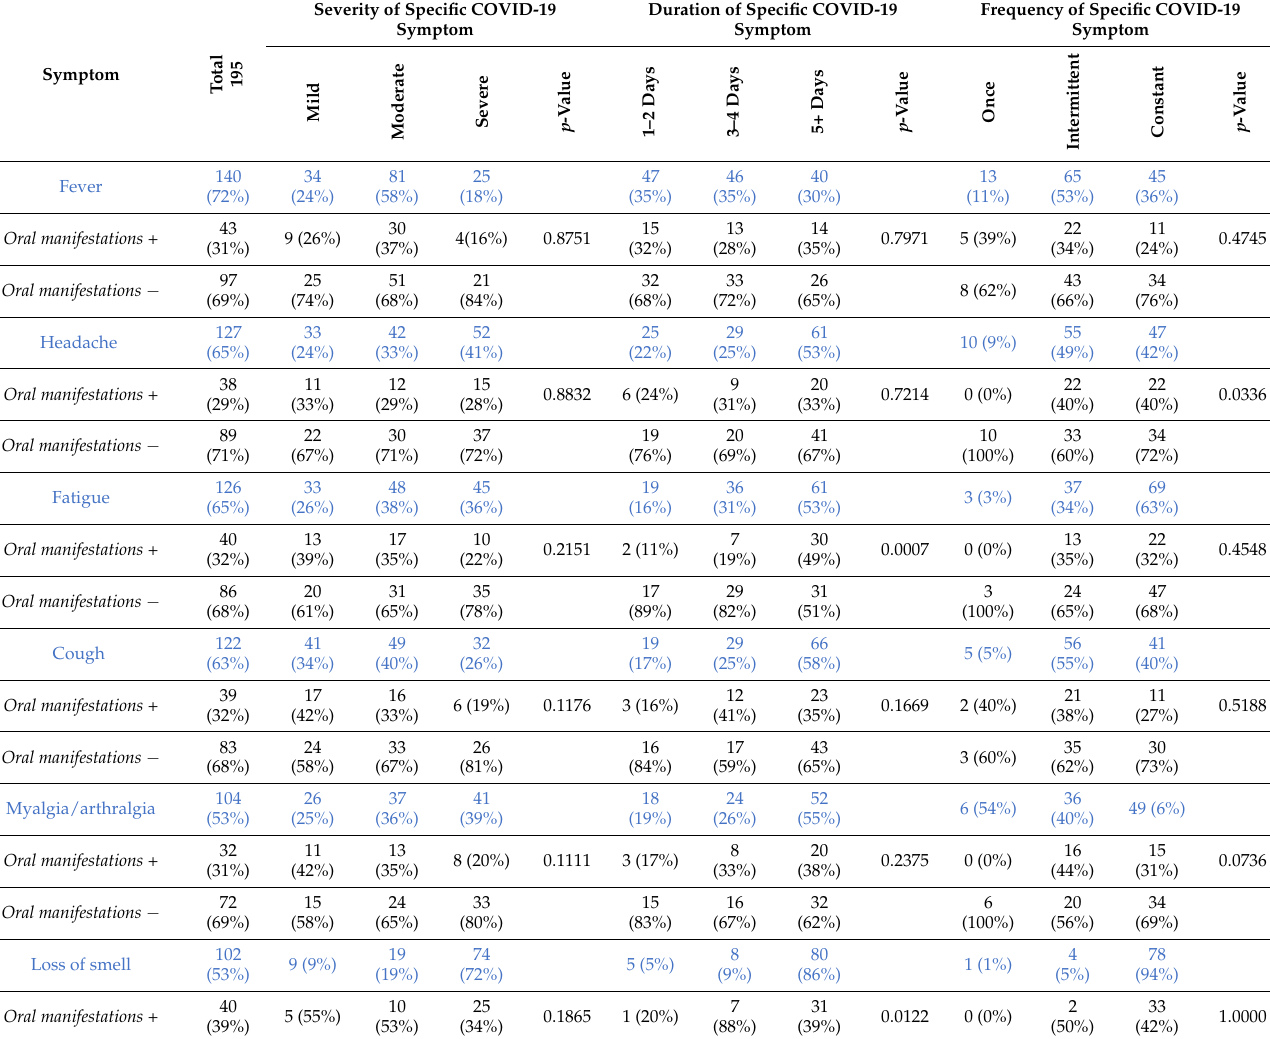
Table 2. Relationships between general symptoms of COVID-19 in terms of severity, duration, and the frequency and presence of oral manifestations of